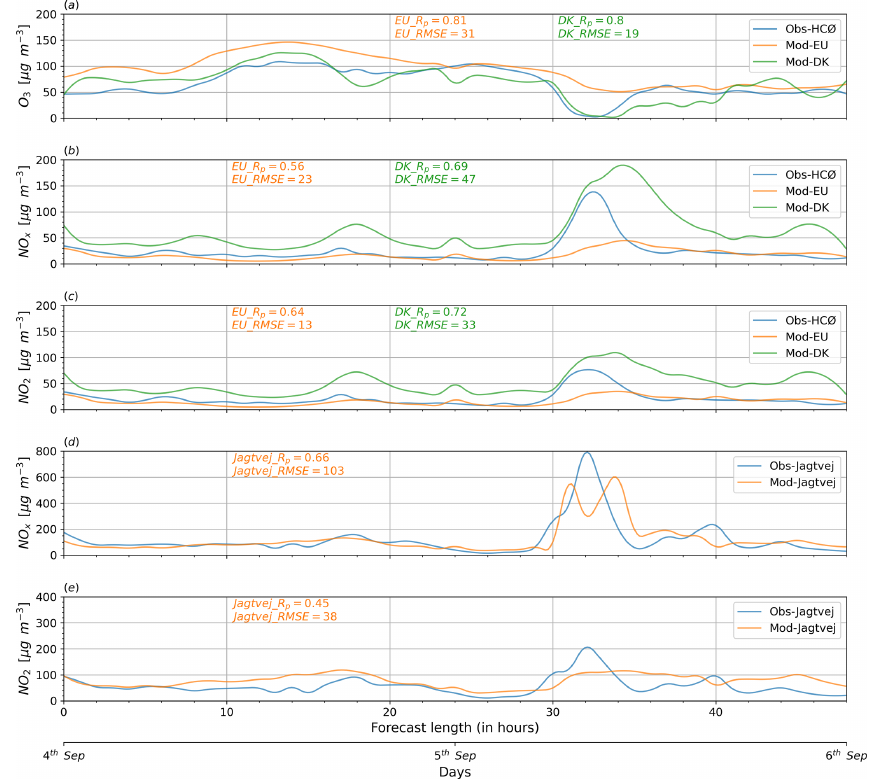
Figure 4. Time series of observations vs. HIRLAM + CAMx + M2UE forecasts for (a) O 3 , (b, d) NO x and (c, e) NO 2 for the European, Denmark, and Copenhagen modeling domains during Sunday–Monday 4–5 September 2011; (a, b, c) HCØ roof level observations of O 3 , NO x , and NO 2 vs. modeling results for EU and DK domains; (d, e) Jagtvej Street level observations of NO x and NO 2 vs. M2UE. Pearson correlation R p and root mean square error RMSE of modeled vs. observed concentrations for three